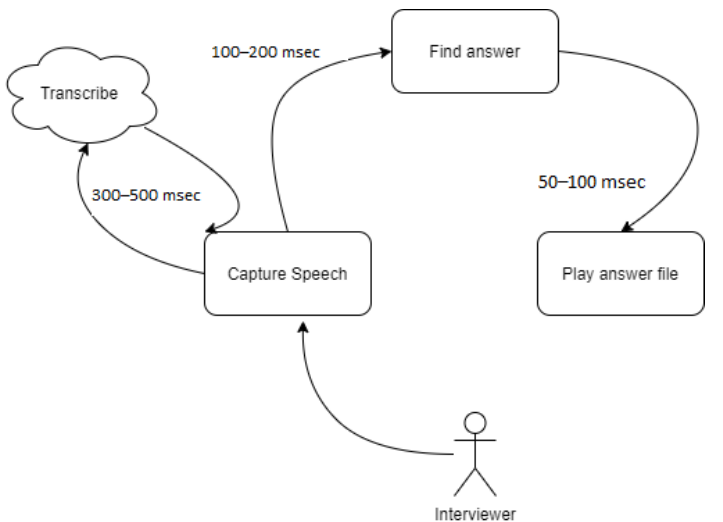
Figure 7. Average latency and delays across the modules involved in recording a question and returning an answer. Round trip time takes at most 700 msec with a stable internet connection of at least 1